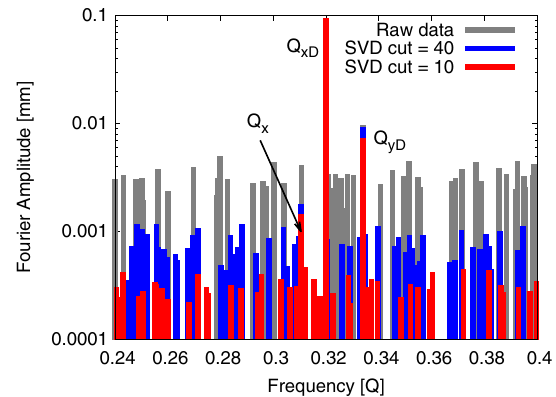
FIG. 5. Frequency spectrum of an LHC arc BPM with an oscillation amplitude of 1 (cid:6) . Both horizontal and vertical ac dipole drive frequencies ( Q xD and Q yD ) are observed in the spectrum. The natural tune is within the noise floor for the raw data, barely above for an SVD cut of 40 and about a factor 5 above for an SVD cut of